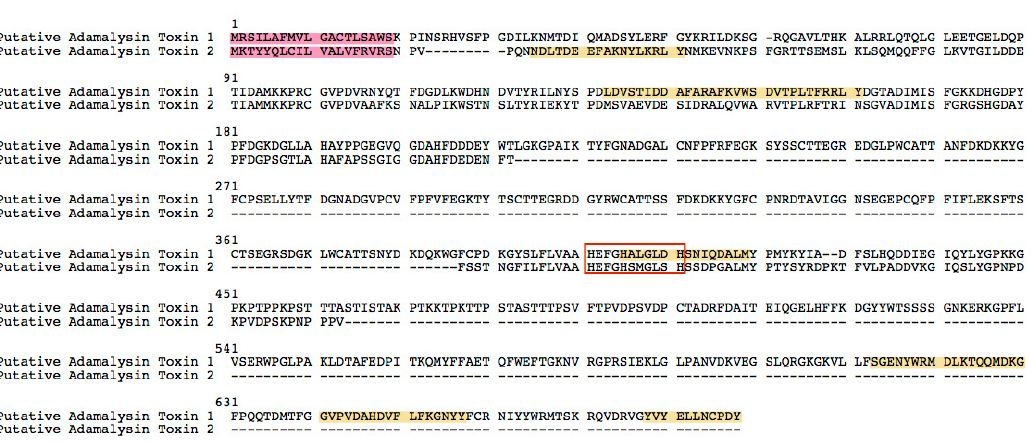
Figure 7. The putative Adamalysin toxin sequences from Chinese yellow catfish. Sequences in red background are signal peptides. Peptides in yellow background are verified by LC-MS/MS analysis. The red box includes the elongated zinc binding consensus sequence HEXXHXXGXXH. Dashed lines means the absence of corresponding amino acid sequences.